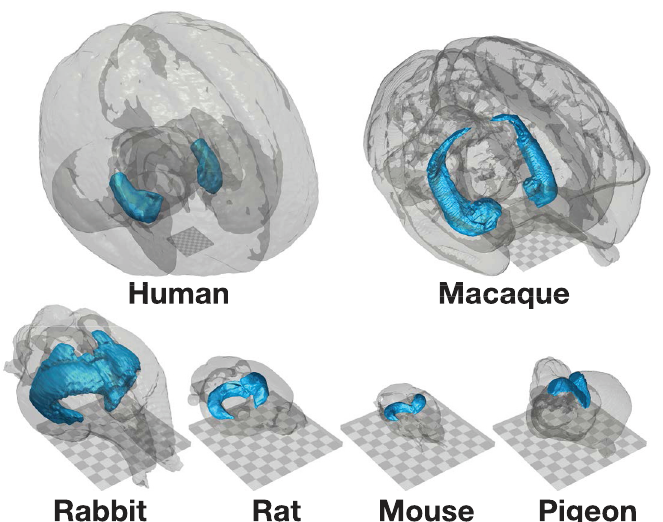
Figure 5. Comparative neuroanatomy of whole-brain and hippocampal brain volumes. The square grid included in each panel measures 20 mm across, with each grid square subtending 2 mm. See Appendix C for details and references describing each brain